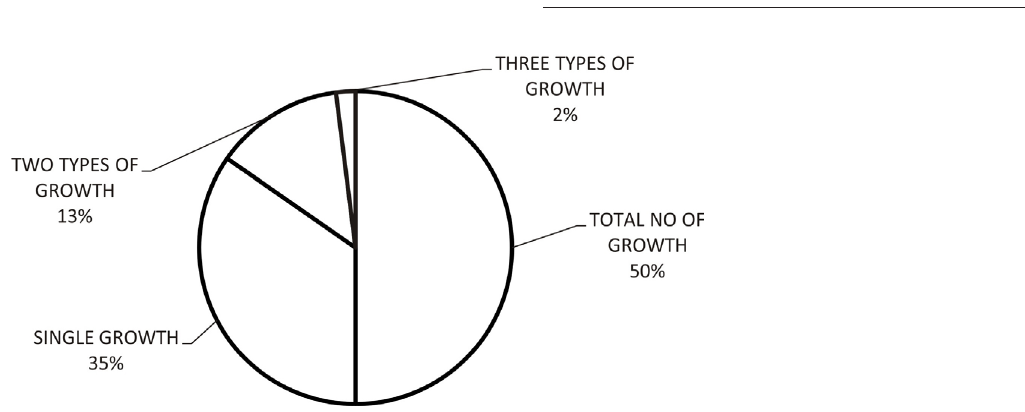
Fig. 1. Growth pattern from 75